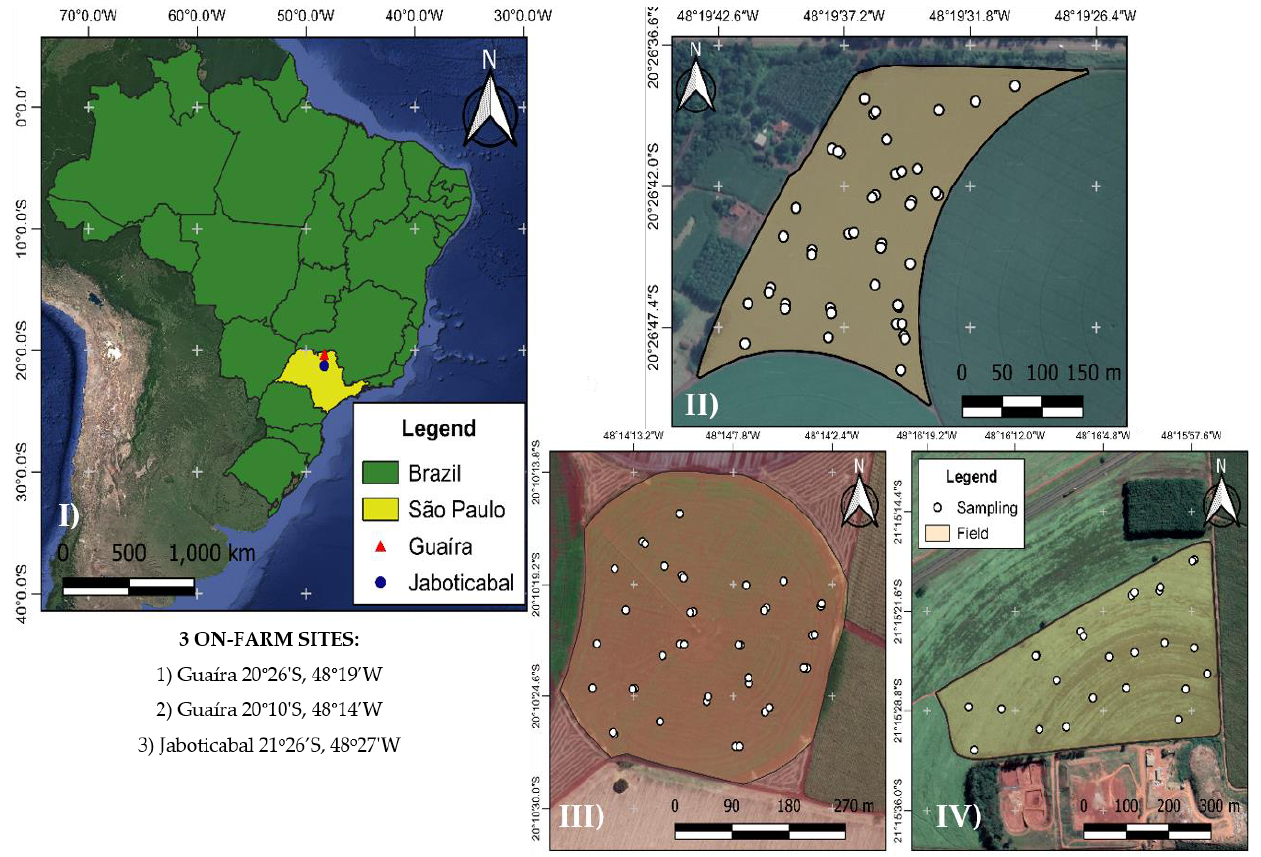
Table 1. Elevation, nematode species identified, and total area (ha) for each site.